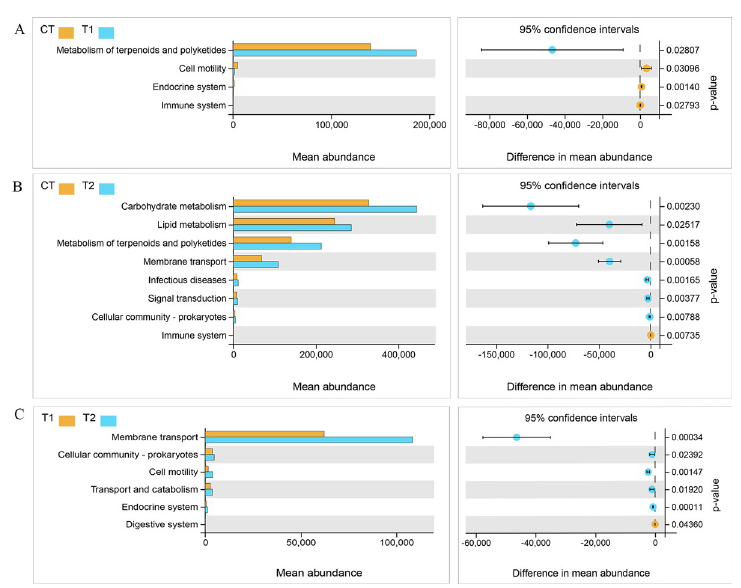
Fig 3. KEGG metabolic pathway difference analysis. Abundance ratios of different functional genes in the (A) T1/ CT, (B) T2/CT and (C) T1/T2 groups. The middle shows the difference in functional gene abundance within a 95% confidence interval, and the right most value is the p-value